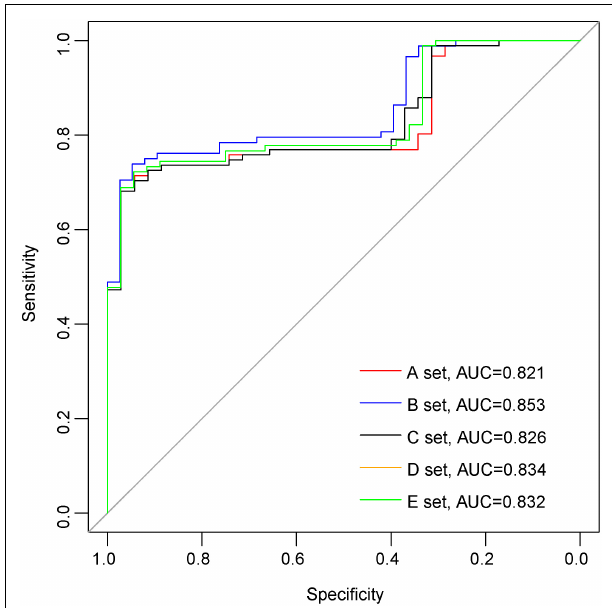
FIGURE 6 | Establishment of logistic regression model. The Receiver operating characteristic (ROC) curve for predicting overall outcomes by logistic regression